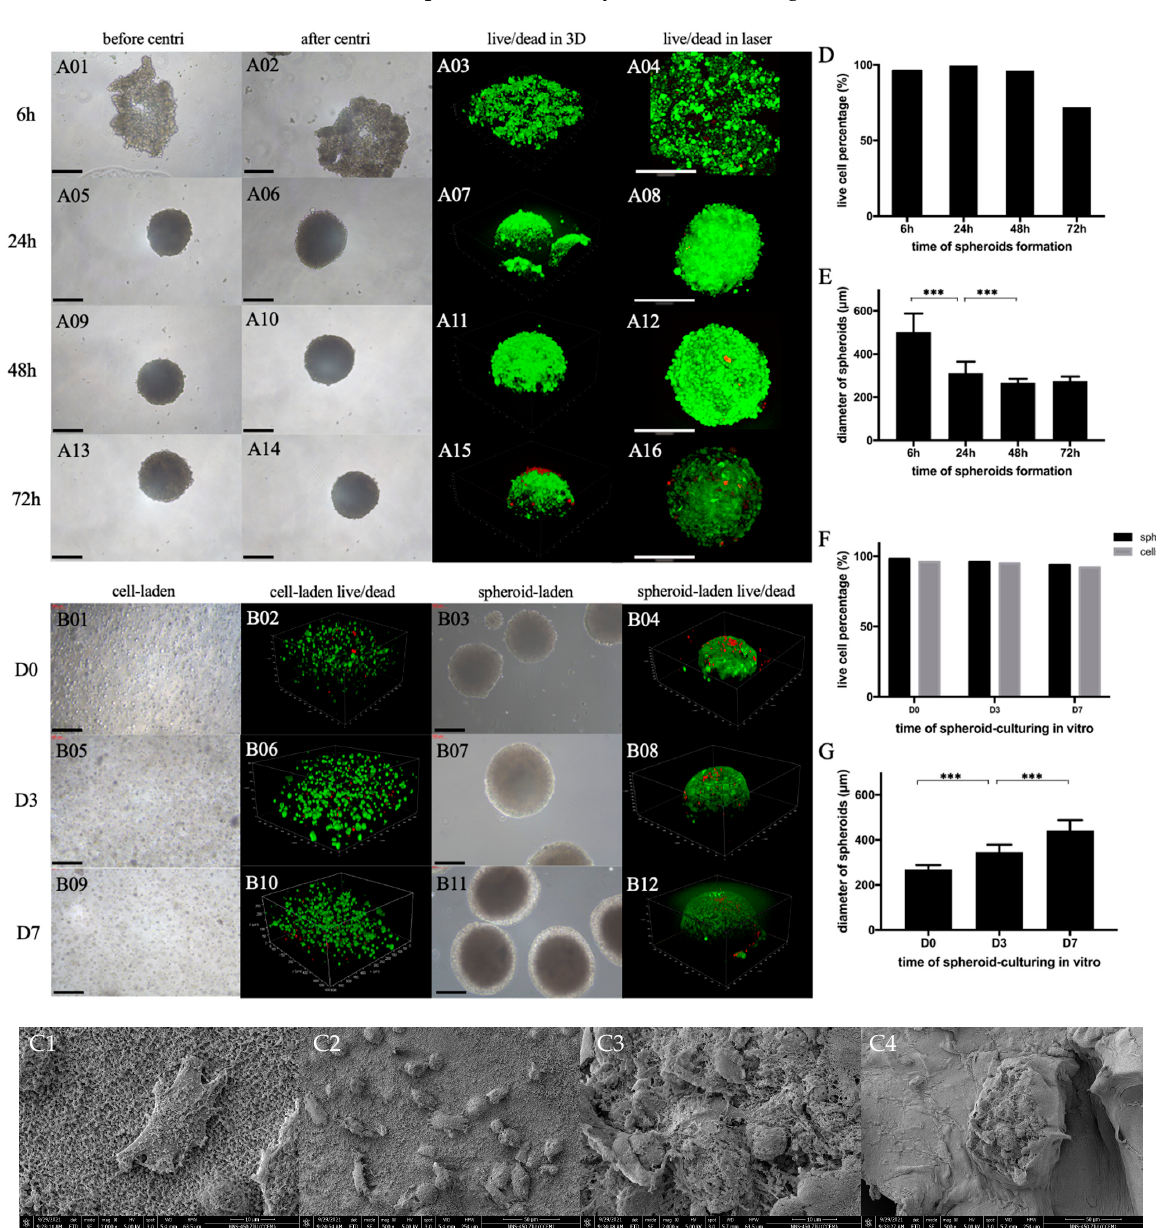
Figure 3. ( A ) The process of spheroid formation in the hanging drops over 72 h. The spheroid morphology before centrifugation, after centrifugation, and the live/dead staining outcome in 3D view and vertical view at 6 h ( A01 – A04 ), 24 h ( A05 – A08 ), 48 h ( A09 – A12 ), and 72 h ( A13 – A16 ), respectively. Inverted microscopy: 10×, confocal microscopy: 25×. Scale bar = 200 µm. ( B ) In vitro culturing of spheroid-laden hydrogel constructs and cell-laden hydrogel constructs. The cell morphology, the live/dead staining outcome of cells, the spheroid morphology, the live/dead staining outcome of spheroids at day 1 ( B01 – B04 ), day 3 ( B05 – B08 ), and day 7 ( B09 – B12 ), respectively. Inverted microscopy: 10×. Confocal microscopy: 25×. Scale bar = 200 µm. ( C ) The SEM images of cell-laden hydrogel constructs ( C1 , C2 ) and spheroid-laden hydrogel constructs ( C3 , C4 ). Scale bar as shown in figures. Dispersed chondrocytes adhered to the hydrogel. Chondrocytes in spheroid are closely connected with each other. ( D ) The percentage of live cells at different time periods during spheroid formation in hanging drops. ( E ) The diameter changes in spheroids during spheroid formation in hanging drops. ( F ) The percentage of live cells at different time periods during the in vitro culturing of hydrogel constructs. ( G ) The diameter changes in spheroids during the in vitro culturing of hydrogel constructs. (*** p < 0.001.)